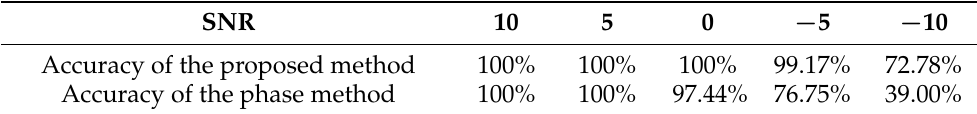
Table 3. Direction finding accuracy comparation under different SNR.